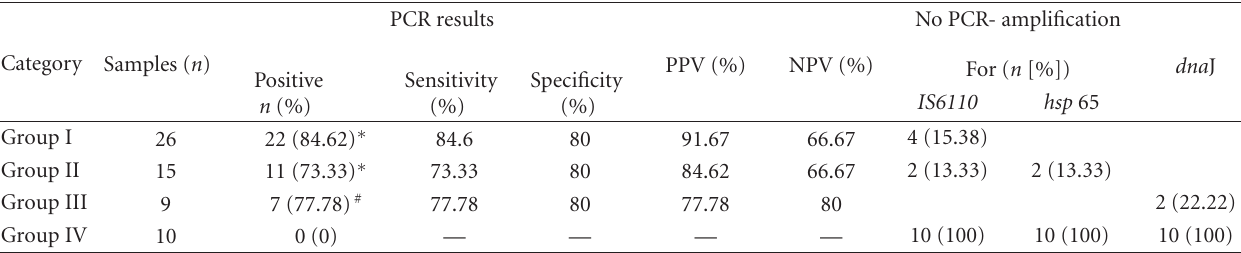
Category Samples ( n )